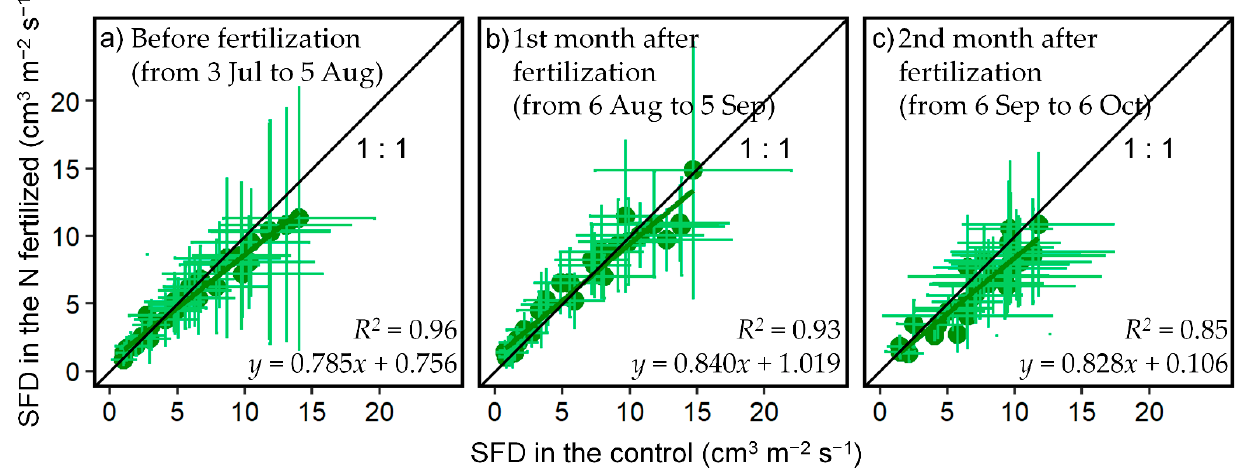
Figure 2. The diurnal variation of ( a – c ) photosynthetic active radiation (PAR; purple circles ), vapor pressure deficit (VPD; orange circles ), and ( d – f ) mean sap flow density (SFD) in the control ( light blue circles ) and the N ‐ fertilized ( yellow circles ) plots. Error bars in ( d – f ) are the standard deviation of SFDs in individual trees ( n = 11–14). The dates used were ( a , d ) 2 August 2019, ( b , e ) 6 August 2019, and ( c , f ) 10 September 2019.